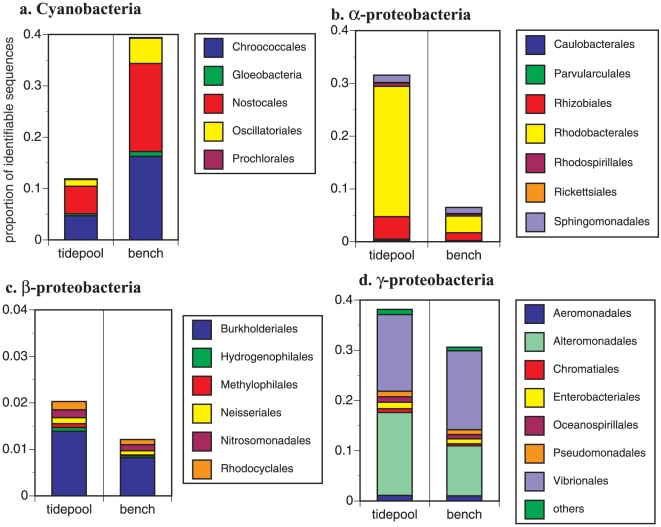
The relative proportional representation within the most commonly discovered bacterial orders on the surface of the mussel shells.a. Cyanobacteria, b. α-Proteobacteria, c. β-Proteobacteria, and d. γ-Proteobacteria among the tidepool and emergent mussel shells samples. Y-axes differ due to differences in relative abundance (see Fig. 1a).